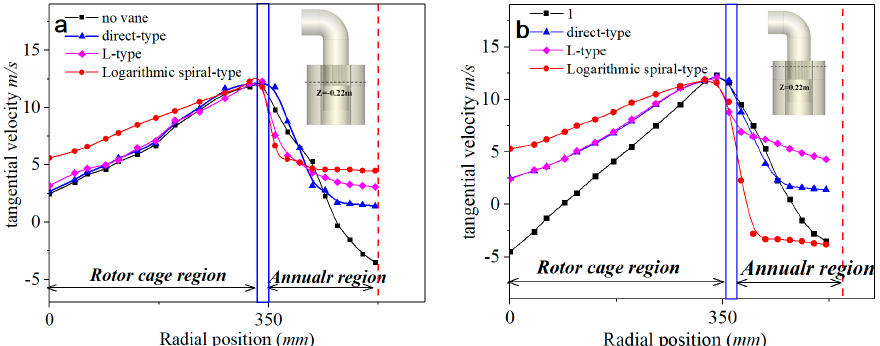
Figure 7. Comparison of the tangential velocity distribution of rotor cage by four different guide vanes in two sections ( a ) Z = − 0.22 m, ( b ) Z = 0.22 m.